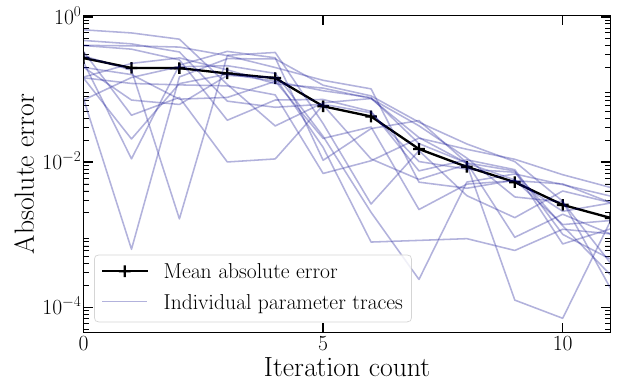
FIG. 5. Learning small couplings of a six-spin cluster within ubiquitin given a fixed backbone from a noisy dataset with stan- dard deviation 10 − 3 . The system is learned from a dataset of 21 points equally spaced between 0 and 2 ms (assuming a 23.5-T background magnetic field, and a dipolar suppression of α = 10). Absolute error in individual parameters (blue faint lines) and the mean absolute error (black line) are plotted at each iteration of the conjugate gradient